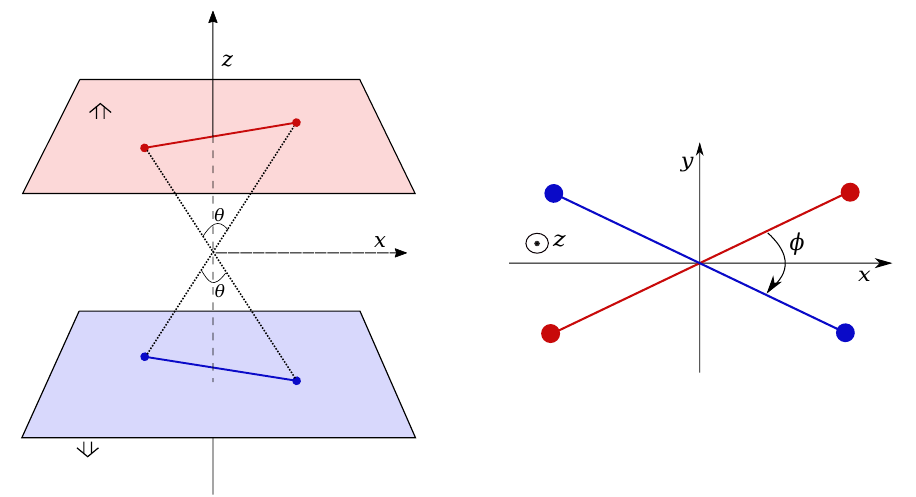
Figure 1: The parallel frame showing the parallel planes of two strings and the open- ing angle θ and skewness angle φ